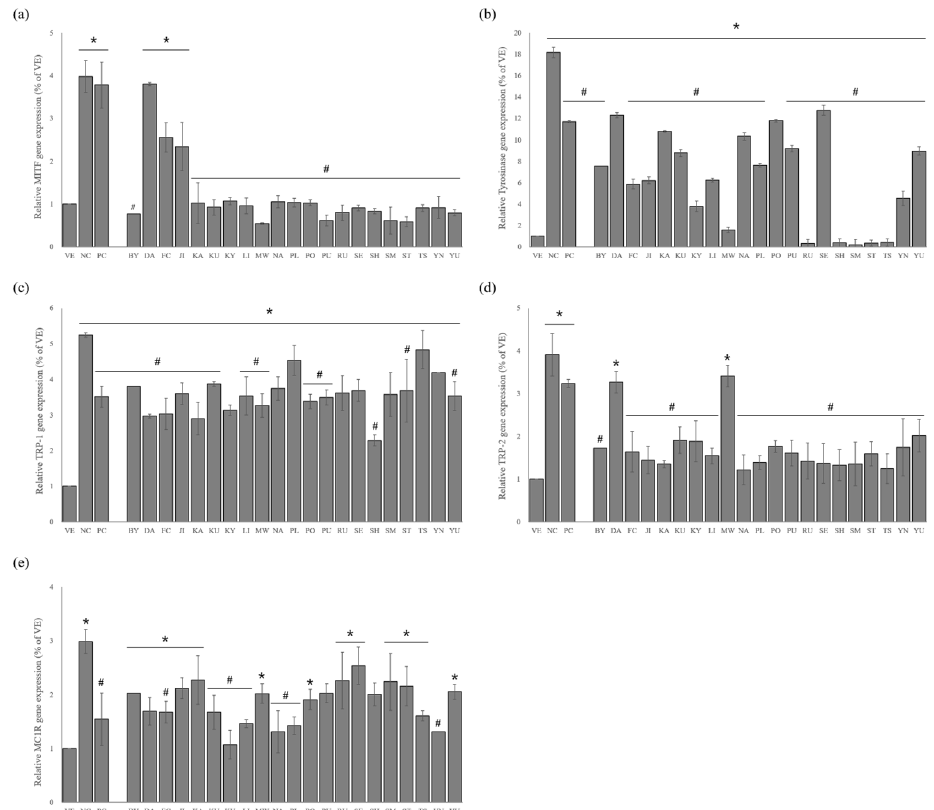
Figure 5. Effects of essential oils on α -MSH-induced B16BL6 cells: ( a ) MITF expression; ( b ) Tyrosinase expression; ( c ) TRP-1 expression; ( d ) TRP-2 expression; ( e ) MC1R expression. Values are presented as means ± standard deviations. Note: * p < 0.05 compared to VE; # p < 0.05 compared to NC. VE, vehicle group; NC, 100 nM α -MSH; PC, 200 µM kojic acid; BY, C. platymamma ; DA, C. maxima ; FC, C. medica ; JI, C. sunki ; KA, C. X aurantium ; KU, C. japonica ; KY, C. unshiu X C. sinensis ; LI, C. limon ; MW, C. reticulata ; NA, C. X aurantium ; PL, C. X latifolia ; PO, C. reticulata ; PU, C. maxima ; RU, C. paradisi ; SE, C. X aurantium ; SH, ( C. unshiu X C. sinensis ) X C. reticulata ; SM, C. reticulata ; ST, (( C. unshiu X C. sinensis ) X C. reticulata ) X C. reticulata ; TS, ( C. unshiu X C. sinensis ) X C. unshiu ; YN, C. sinensis ; YU, C. junos .